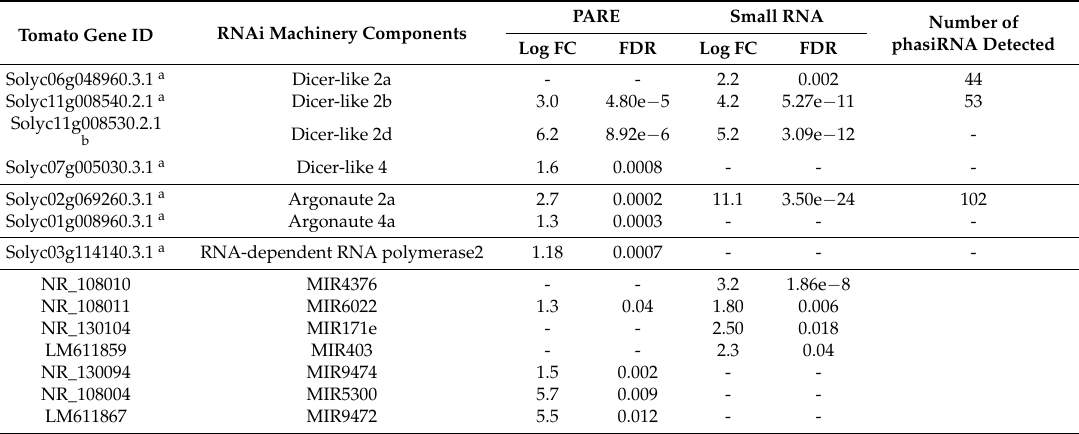
Table 2. Overexpression of the RNAi machinery components in CEVd infected tomato plants. PARE Small RNA Tomato Gene ID RNAi Machinery Components